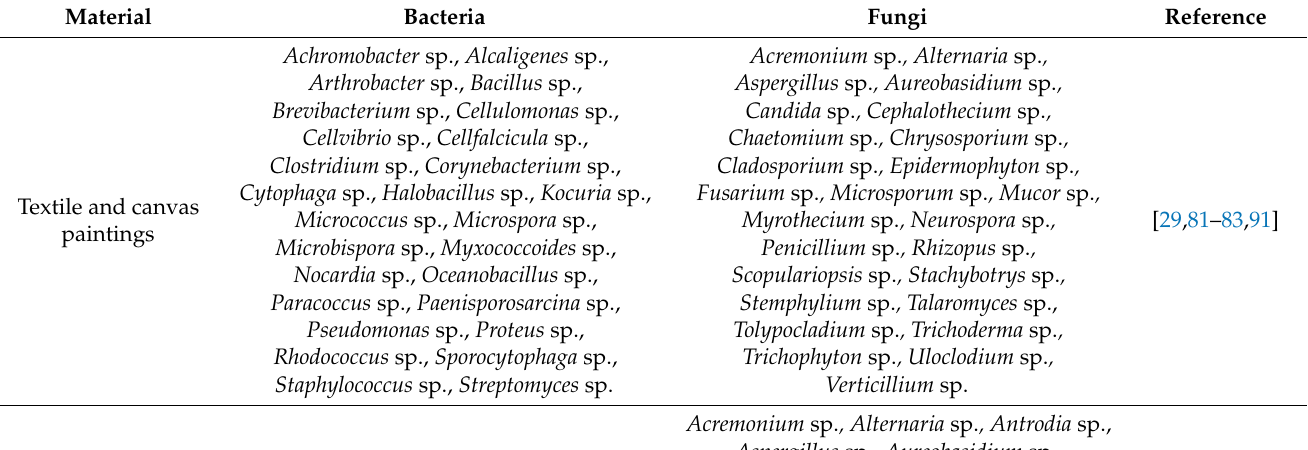
Table 1. Microorganisms associated with biodeterioration of various materials. Material Bacteria Fungi